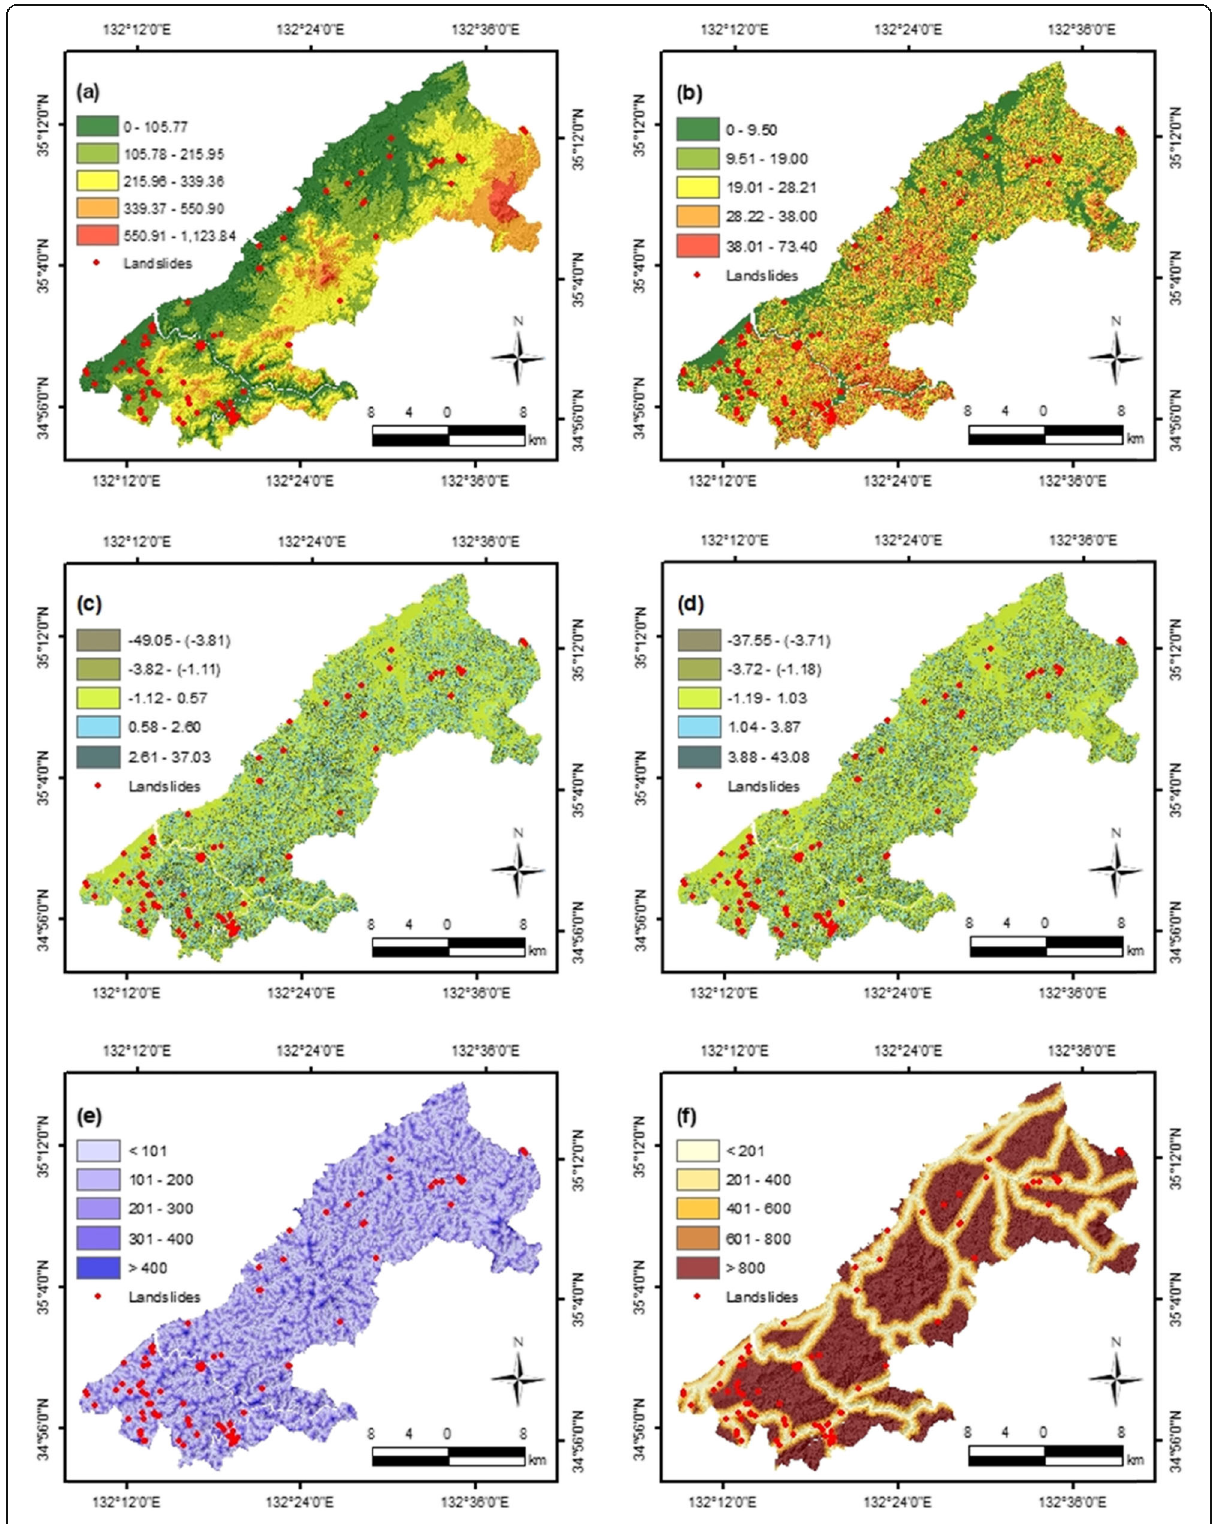
Fig. 3 Thematic maps of topographic factors ( a-d ) and distance to factors ( e and f ) considered in this study: a elevation (m), b slope angle (degree), c plan curvature, d profile curvature, e distance to stream (m), and f distance to road